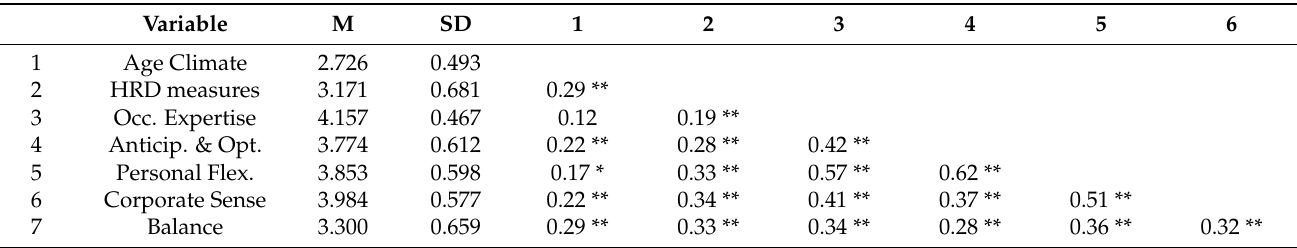
Table 1. Descriptive statistics and